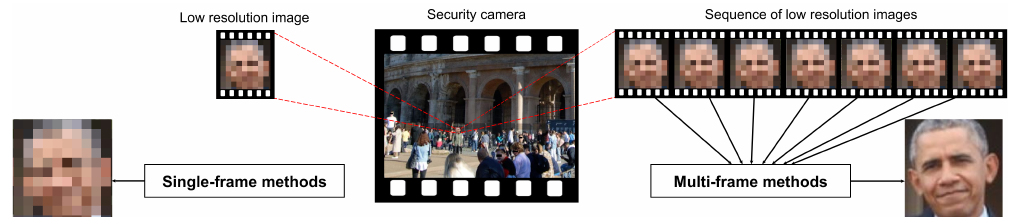
Figure 1. This paper is inspired by the human capacity to recognize a face from a sequence of images better than from a still